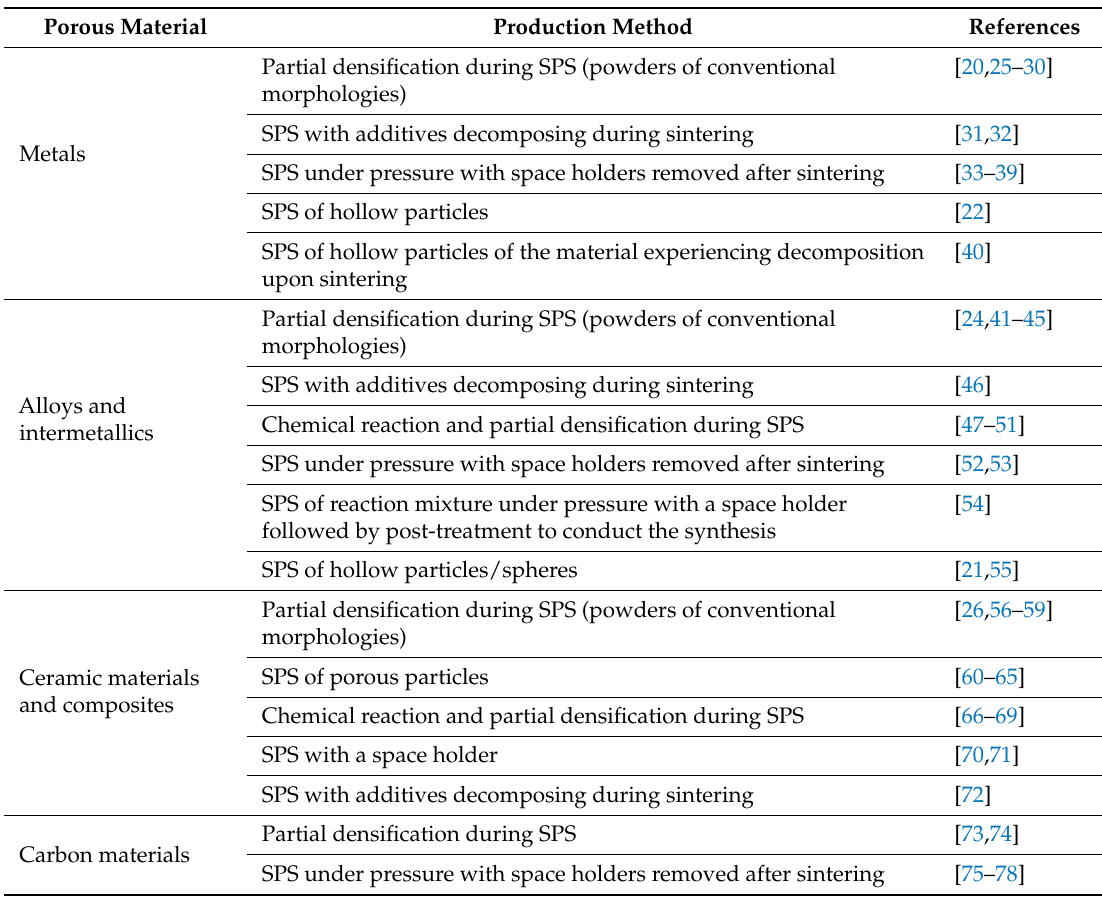
Table 1. Examples of porous materials obtained by